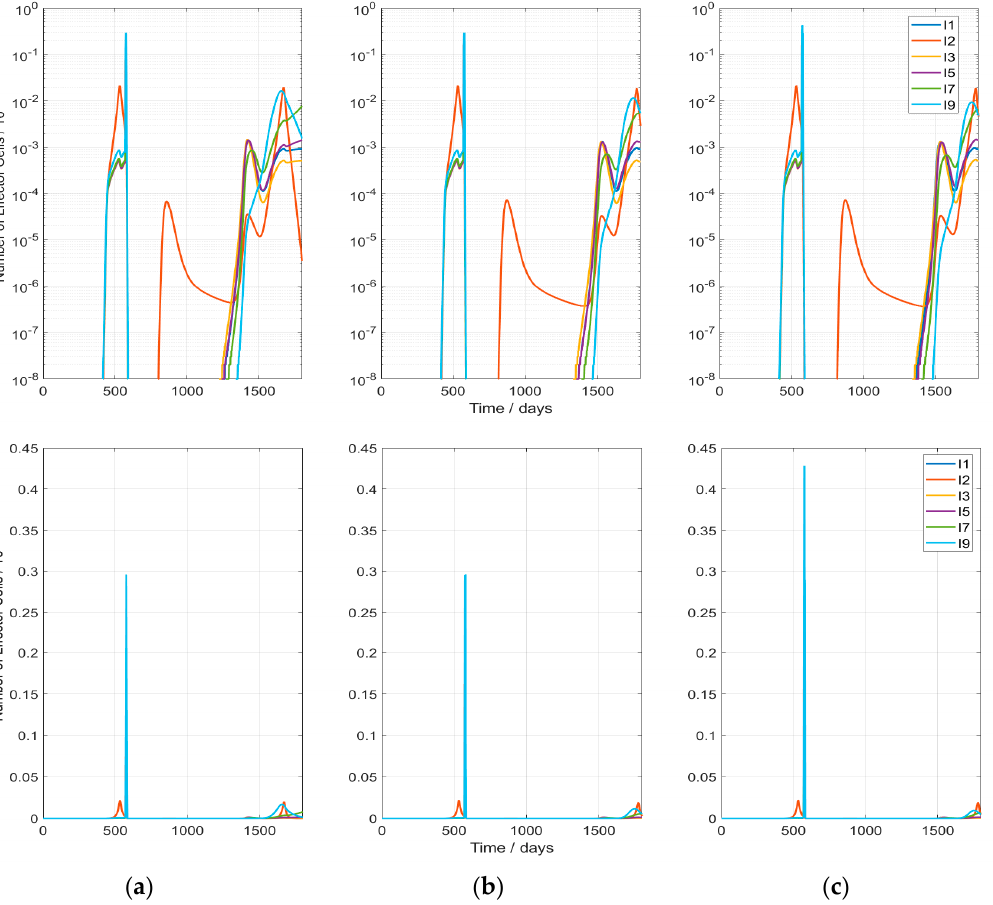
Figure 4. Development of effector immune cells in case of HT-induced modification of all parameters (last column in Table 4): For the host-related effector cells, only the population I2 (red line) is displayed; the other host-associated populations behave identically. The scenarios presented here correspond to ( a ) Case with no HT (RT1HT0); ( b ) Case RT1HT3; ( c ) Case RT1HT2; upper figures with logarithmic axis.